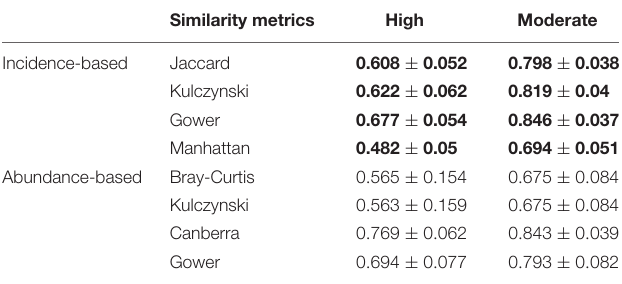
TABLE 1 | Stochasticity in UCYN-A community assembly estimated by different indices based on various similarity metrics. Similarity